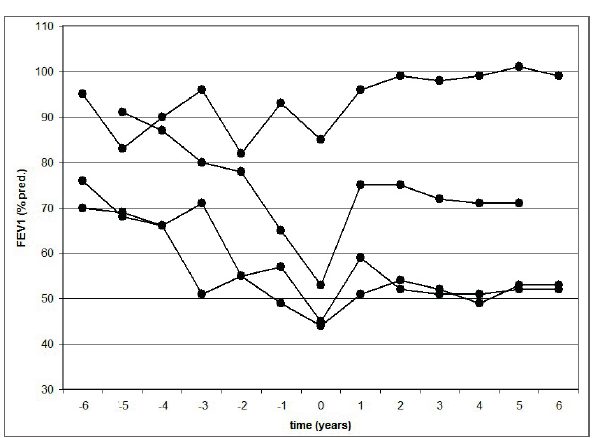
Fig. 1. Change in FEV participants.